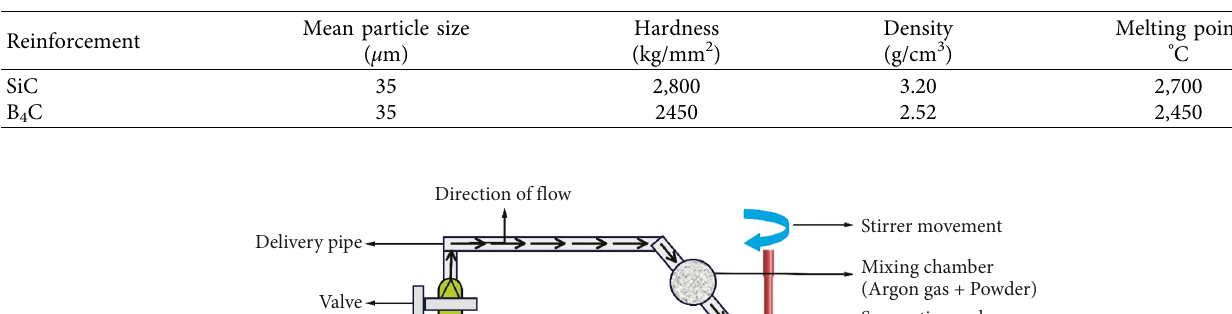
Table 3: Particulars of SiC and B